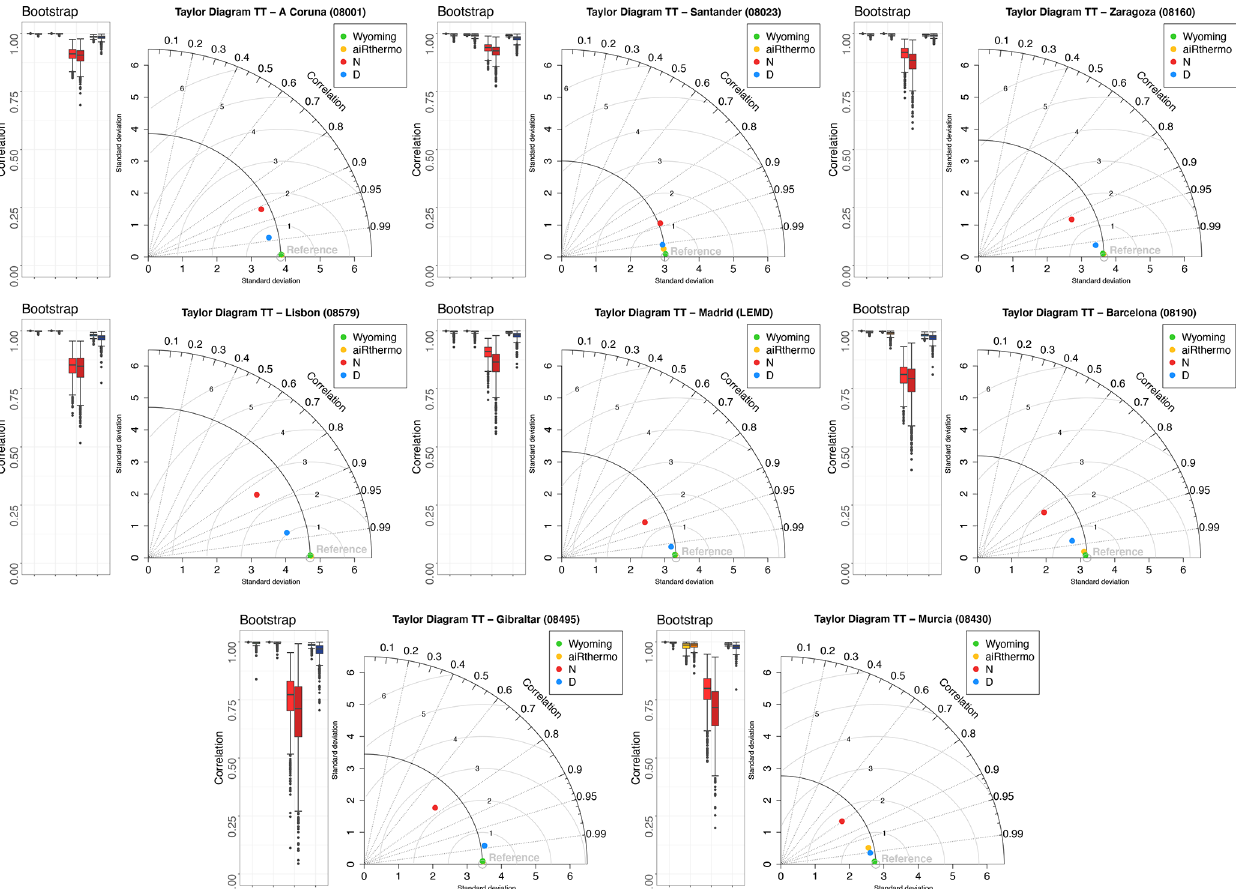
Figure 2. Taylor diagrams showing the r , RMSE, and SD values for Wyoming, aiRthermo, N, and D compared to TT values computed from IGRA (Reference). On the left side of each Taylor diagram, a box-and-whisker plot is added in order to show the Pearson and Spearman correlations between each experiment and the reference data (lighter and darker colours, or first and second columns of the box-and-whisker plots respectively). The bootstrap technique with resampling was used to create 1000 synthetic time series. Wyoming, aiRthermo, N, and D are plotted in green, orange, red, and blue